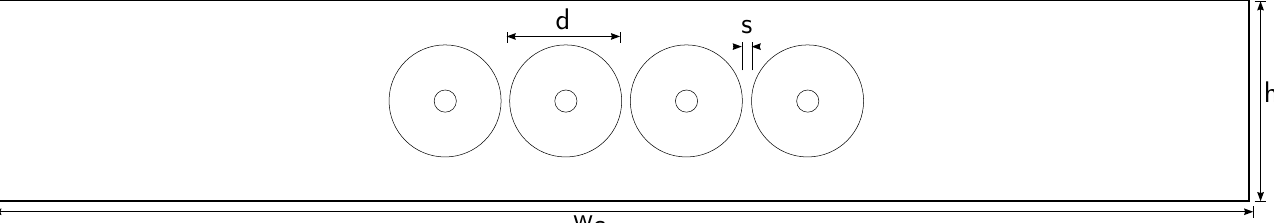
Fig. 1. Diagram of the computational domain for the four rotor fence at the rotor plane. d is the turbine diameter, s is the inter-turbine tip-to-tip spacing, h is the channel depth, and w c is the channel width.